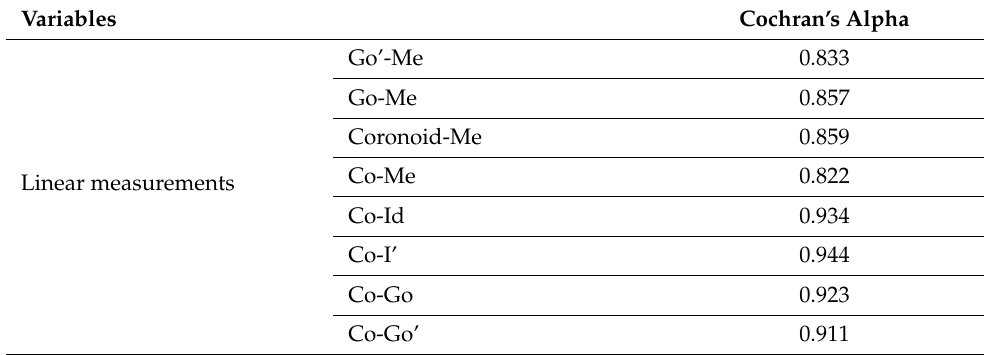
Table 4. Reliability test performed on 10 randomly selected subjects re-measured 3 weeks apart.